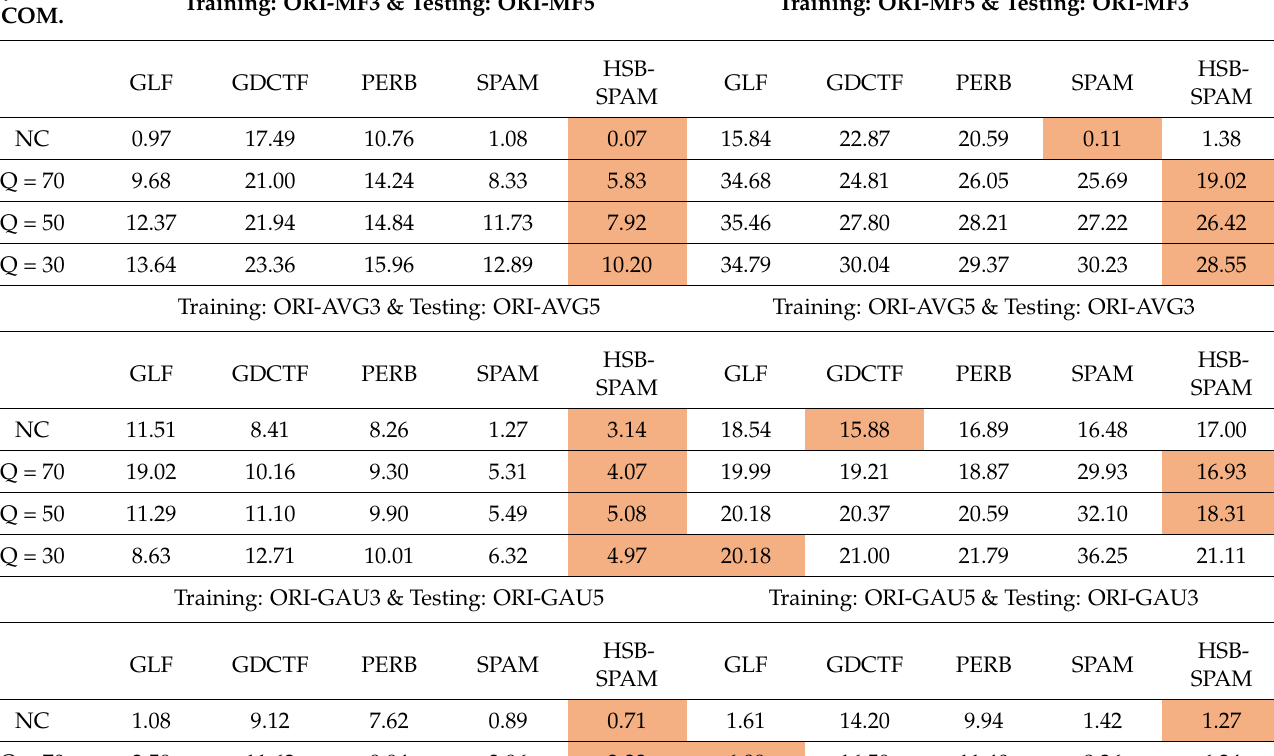
Table 6. Percentage of detection error for different filter size on training and testing